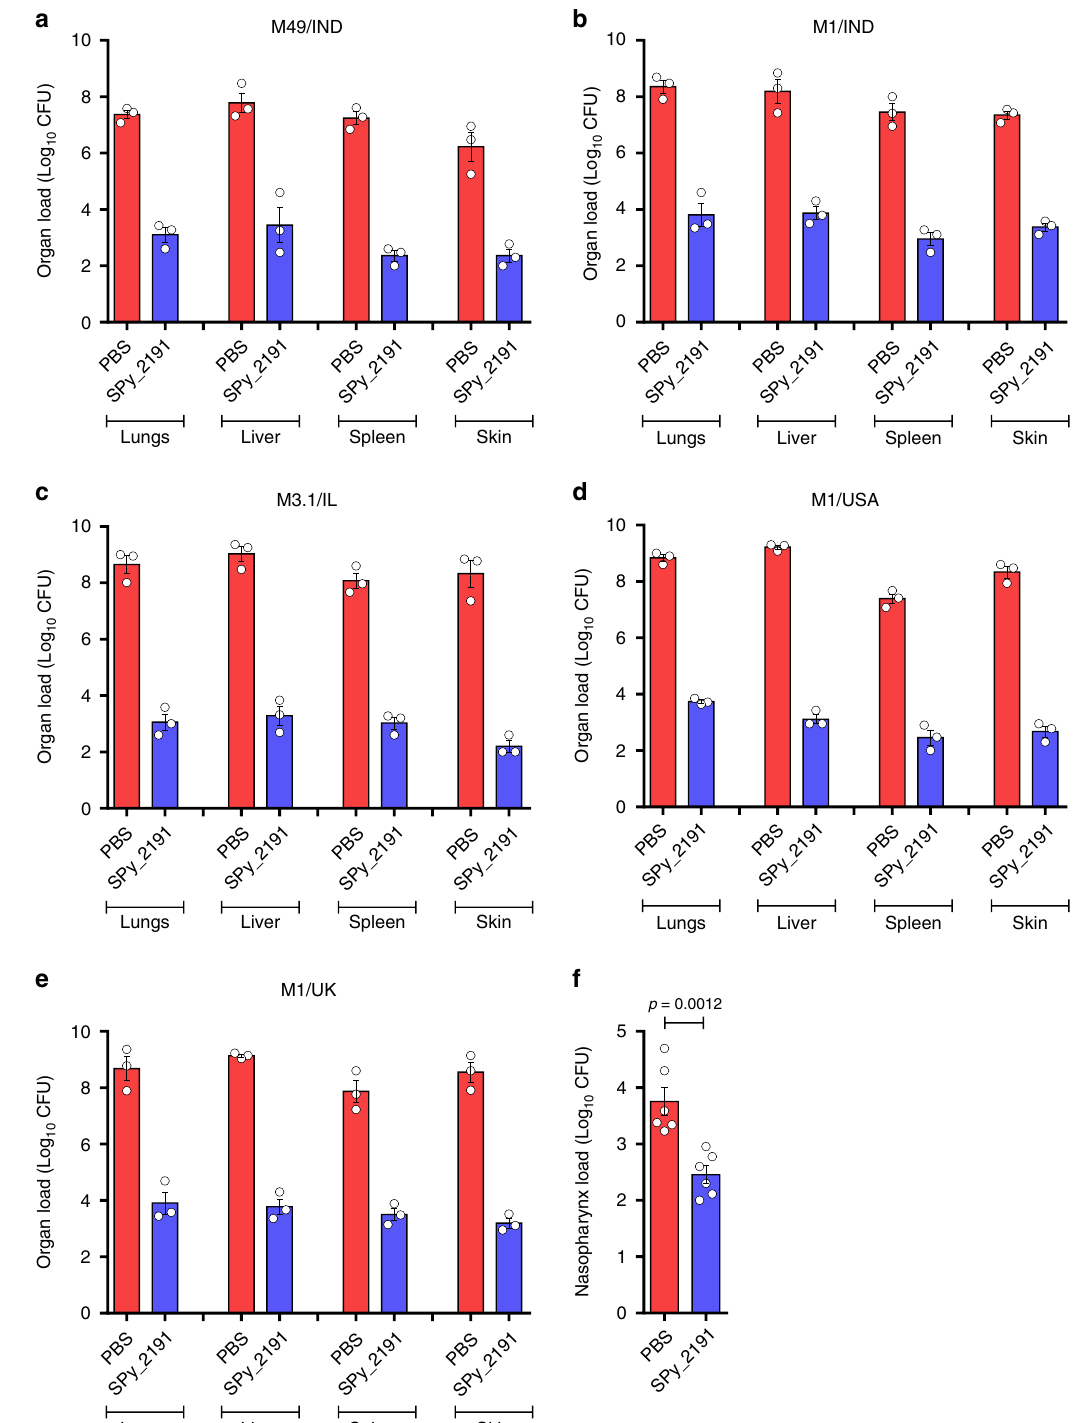
Fig. 4 SPy_2191 immunization reduced organ load post-challenge with different GAS serotypes. Two weeks after the fi nal booster immunization with SPy_2191, C57BL/6 mice were challenged intraperitoneally with different GAS serotypes. Four days post-challenge, three mice from both SPy_2191- immunized and placebo groups were sacri fi ced, and the bacterial load (represented as Log 10 CFU) was enumerated in the liver, lungs, spleen and skin. a – d and e represents data of different organ load after challenge with M49/IND, M1/IND, M3.1/IL, M1/USA, and M1/UK serotypes, respectively. Red bar represents CFUs obtained from PBS control mice and blue bar represents CFUs obtained from SPy_2191-immunized mice. In case of all the organs, across all the infected serotypes, SPy_2191 effectively reduced the bacterial load compared to the placebo group (minimum signi fi cance p < 0.01). f The nasopharyngeal streptococcal load in SPy_2191 and PBS-immunized mice ( n = 6), 5 days post-intranasal challenge with GAS M9/UK (** P < 0.01). Data are presented as mean values ± SEM. The level of signi fi cance was checked by using two-tailed unpaired t